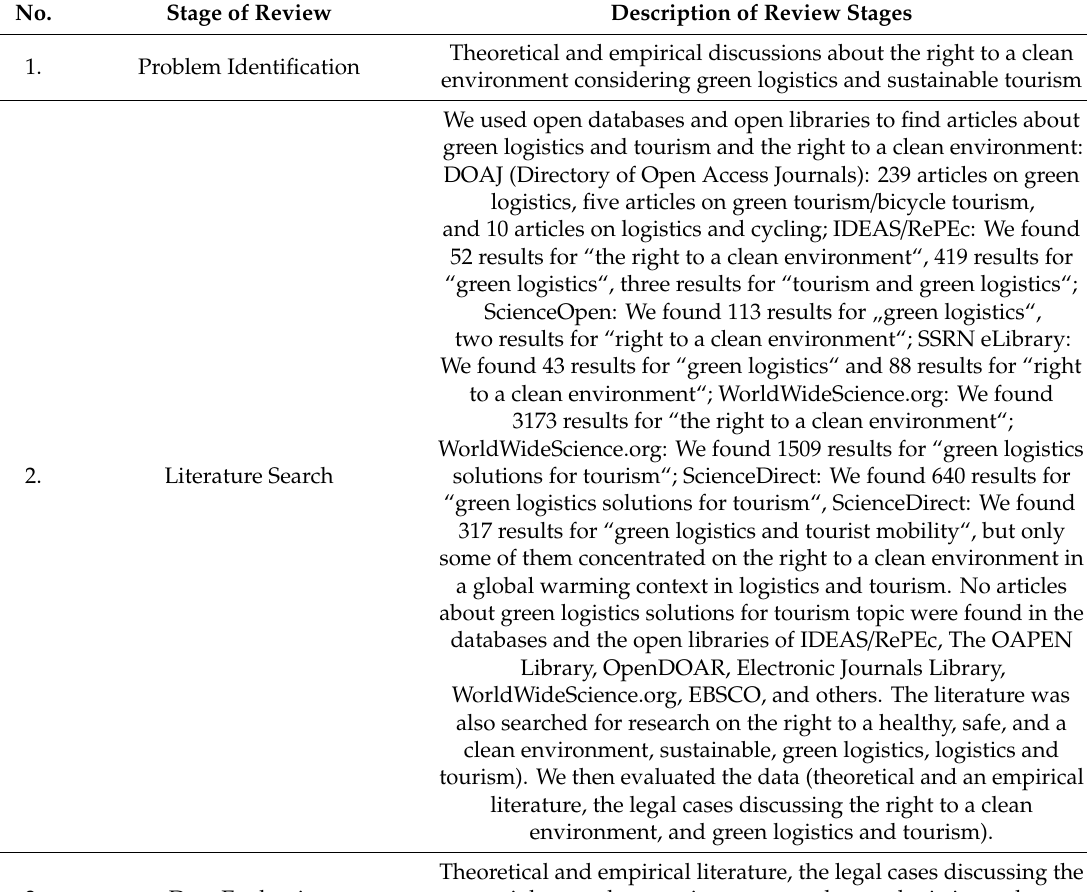
Table 1. The stages of the